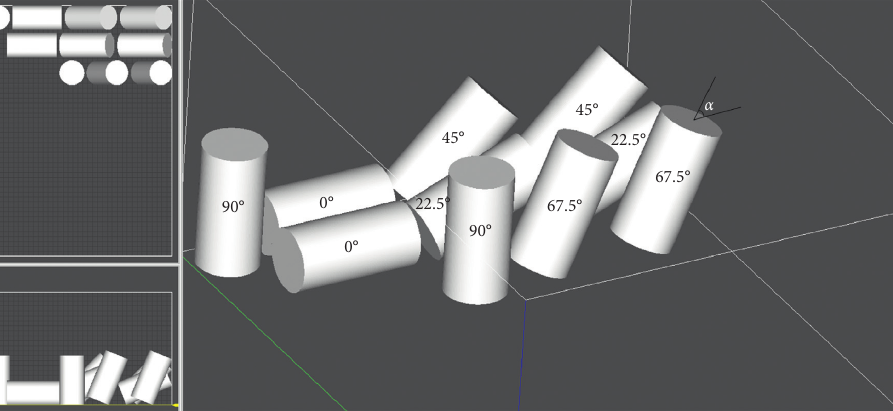
Figure 7: Different inclined angles.